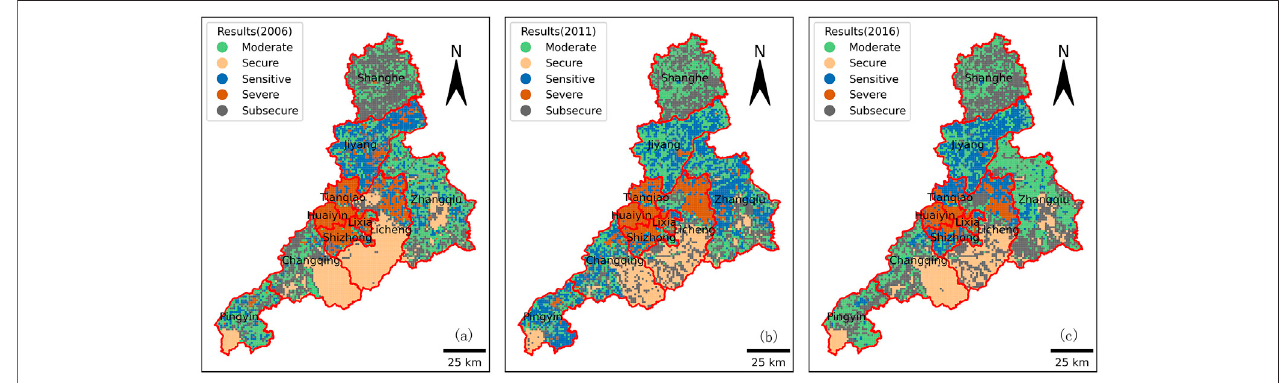
FIGURE 4 | Land ecological security of Jinan from 2006 to 2016. (A – C) represent the results in 2006, 2011 and 2016.